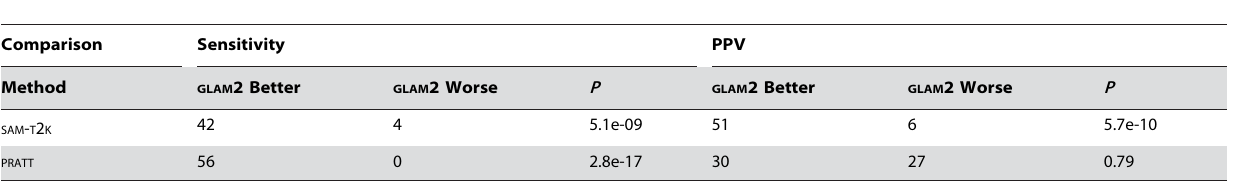
Table 1. Comparison of GLAM 2 with SAM - T 2 K and PRATT on 58 PROSITE motifs.